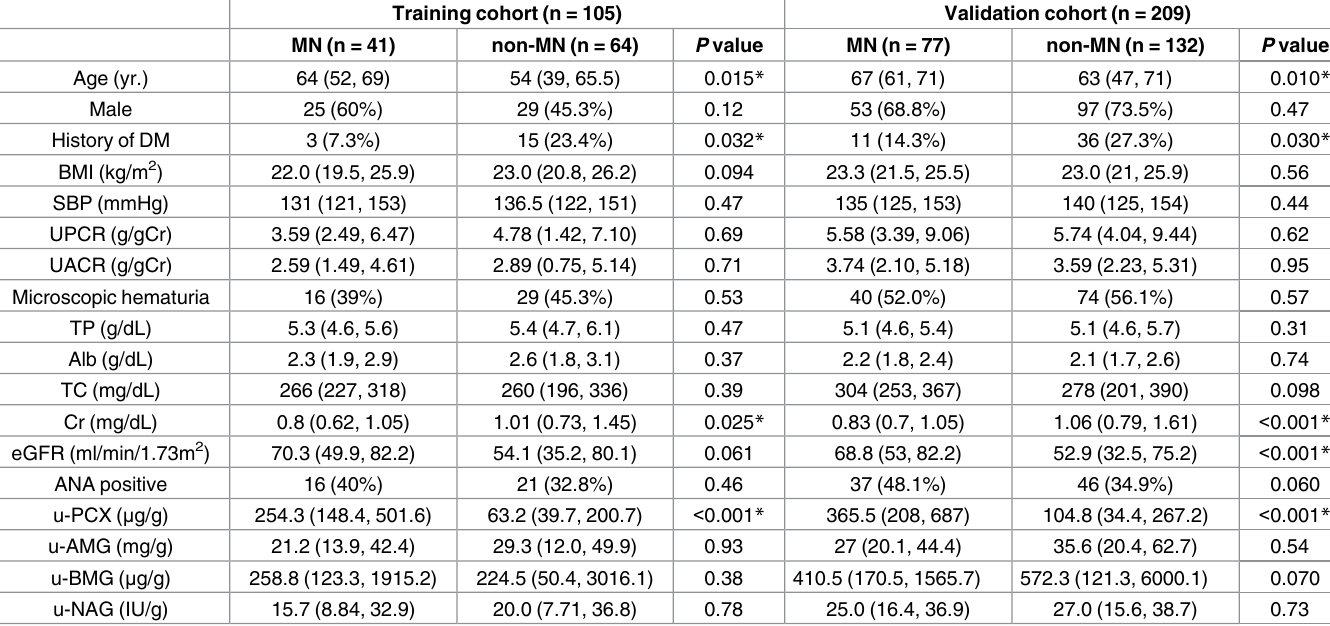
Table 1. Baseline characteristics in training cohort and validation